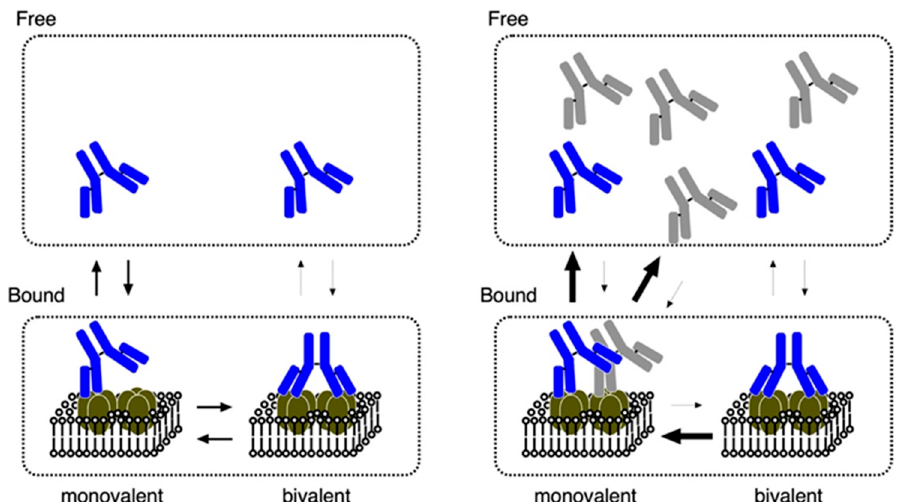
Figure 3. Schematic illustrations of a model for binding modes of E5415A and E5415B to OAPs. Several groups have observed that some antibodies against AQP4 induce endocytosis of AQP4 in cell lines exogenously expressing AQP4 and in primary cultured astrocytes [4,19,25,83,104]. Hinson et al. has demonstrated that M1 is rapidly internalized upon binding of NMO-IgG, whereas M23 is not, using HEK293 cells stably expressing either M1 or M23 [100]. Fluorescence-labeled E5415A was administered to CHO cells expressing either M1 or M23 alone, and it was observed that the fluorescence-labeled E5415A rapidly internalized and accumulated in the intracellular compartment, indicating that both M1 and M23 undergo endocytosis [83]. In cells expressing M1 alone, the level of AQP4 protein was drastically reduced after 24 h of incubation with E5415A and was restored to the basal level if bafilomycin A1, an inhibitor of the vacuolar-type proton pump—which increases the pH value in lysosomes and inhibits protease activity—was simultaneously added, indi- cating that antibody-bound AQP4 was transported to lysosomes and degraded [83]. On